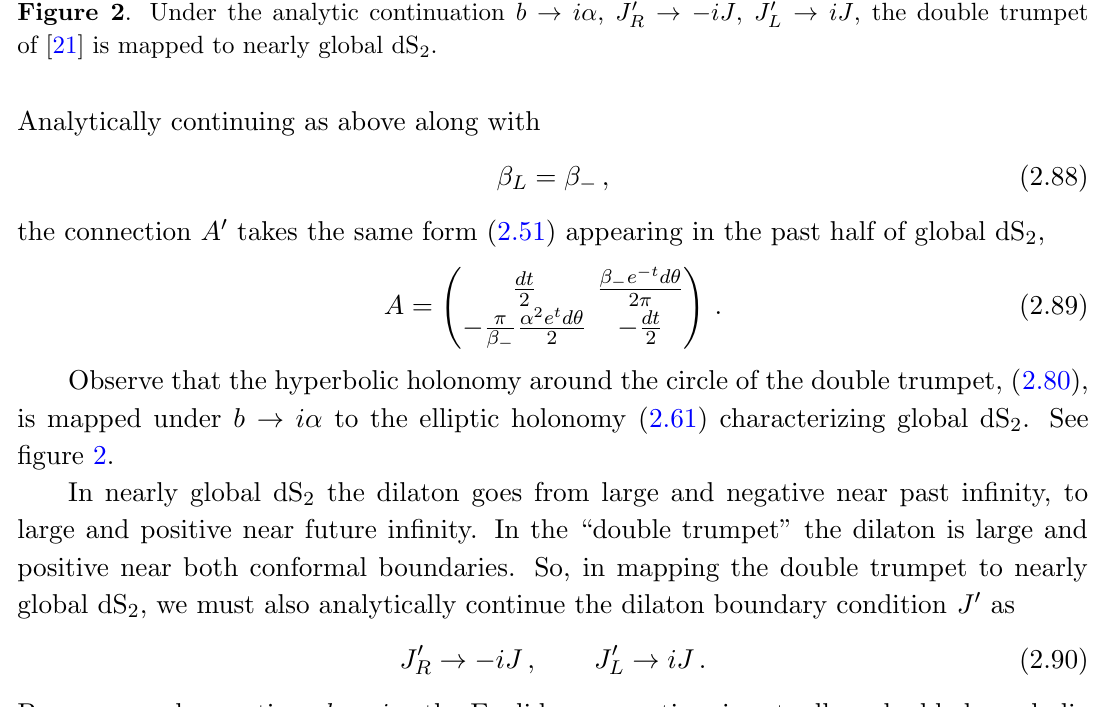
! (cid:0) iJ , J 0 ! iJ , the double trumpet R L